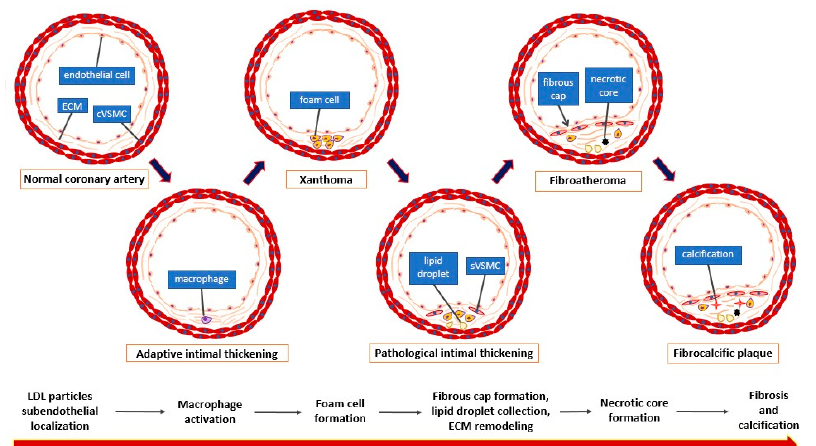
Figure 1. Stages of atherosclerotic plaque development (according to the Virmani classification [6]). cVSMC: vascular smooth muscle cell, contractile phenotype; sVSMC: vascular smooth muscle cell, synthetic phenotype; ECM: extracellular matrix.